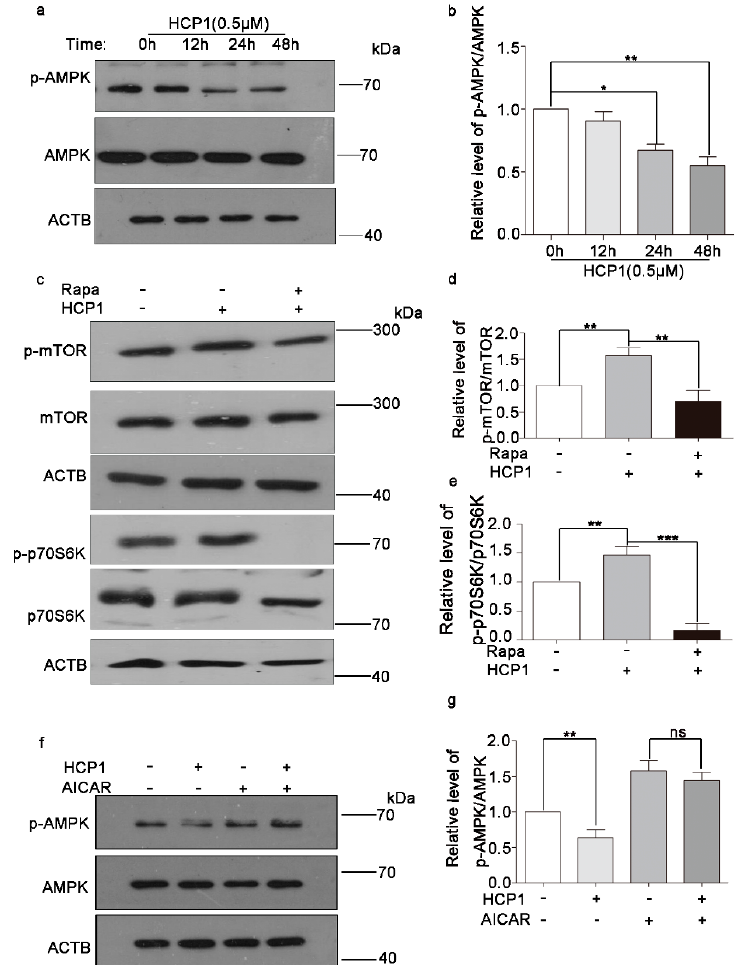
Figure 5. Effects of HCP1 on mTOR/AMPK signal pathway. ( a , b ) HDFs (PDL > 30) were treated with 0.5 μ M HCP1 for 0, 12, 24, 48 h, Western blotting was used to detected the protein level of p-AMPK or AMPK. ( c – e ) HDFs were treated with Rapa or HCP1, Western blotting was used to detected the protein level of the phosphorylation of mTOR and p70S6K. ( f , g ) Western blot analysis of phosphorylation of AMPK α (p-AMPK α ) and AMPK α in HDFs (PDL > 30) treated with HCP1 or AICAR at indicated concentrations for 48 h. Data are presented as means ± SEM, * p < 0.05, ** p < 0.01, *** p < 0.001, ns: p > 0. 05 , n = 3.